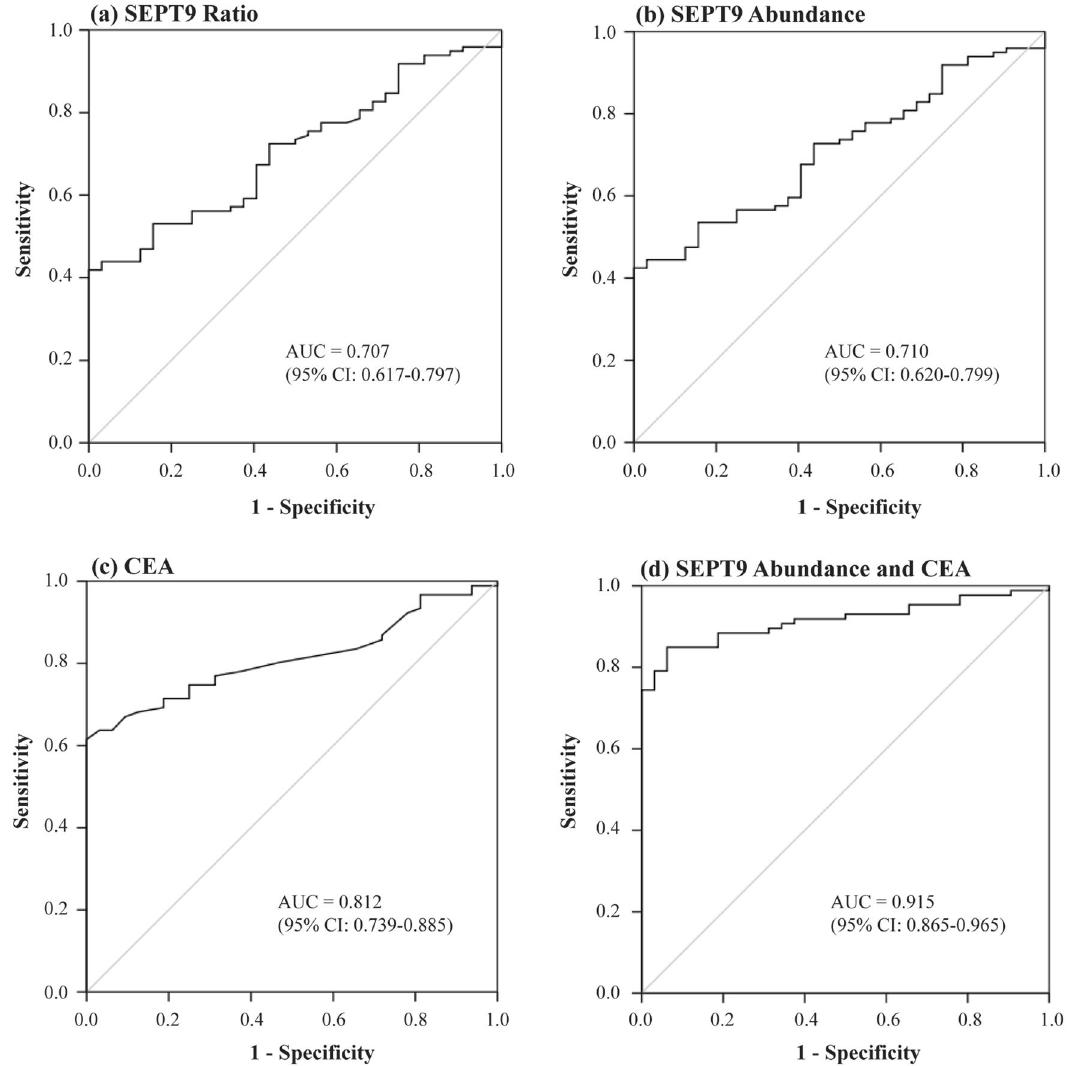
Figure 1. The ROC curve for detecting CRC by SEPT9 methylation and CEA. (a,b) showed the receiver operating characteristic (ROC) curves for septin 9 (SEPT9) methylated ratio and abundance to distinguish colorectal cancer (CRC) patients from normal subjects; (c) the ROC curve for carcinoembryonic antigen (CEA); and (d) the ROC curve of combining CEA and SEPT9 methylated